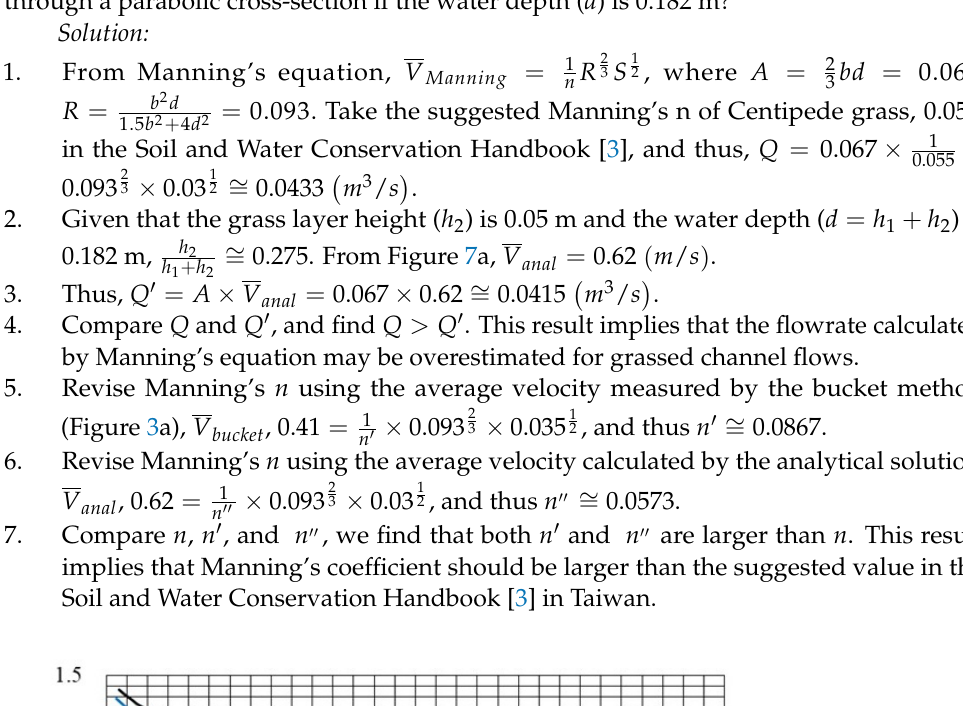
Table 5. Grass layer porosities for different heights and different grass species.